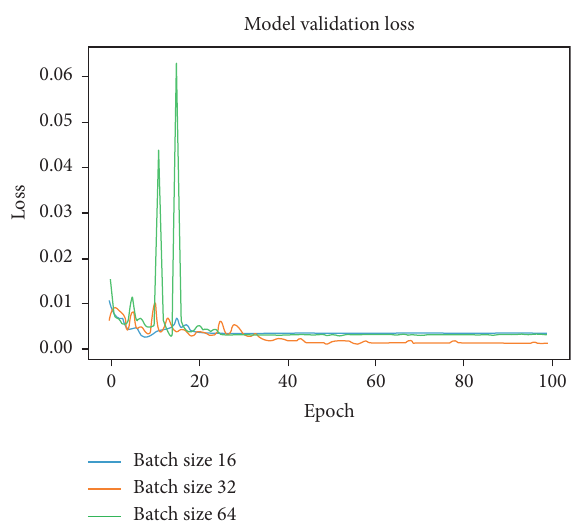
Figure 6: Learning curve with different batch sizes.